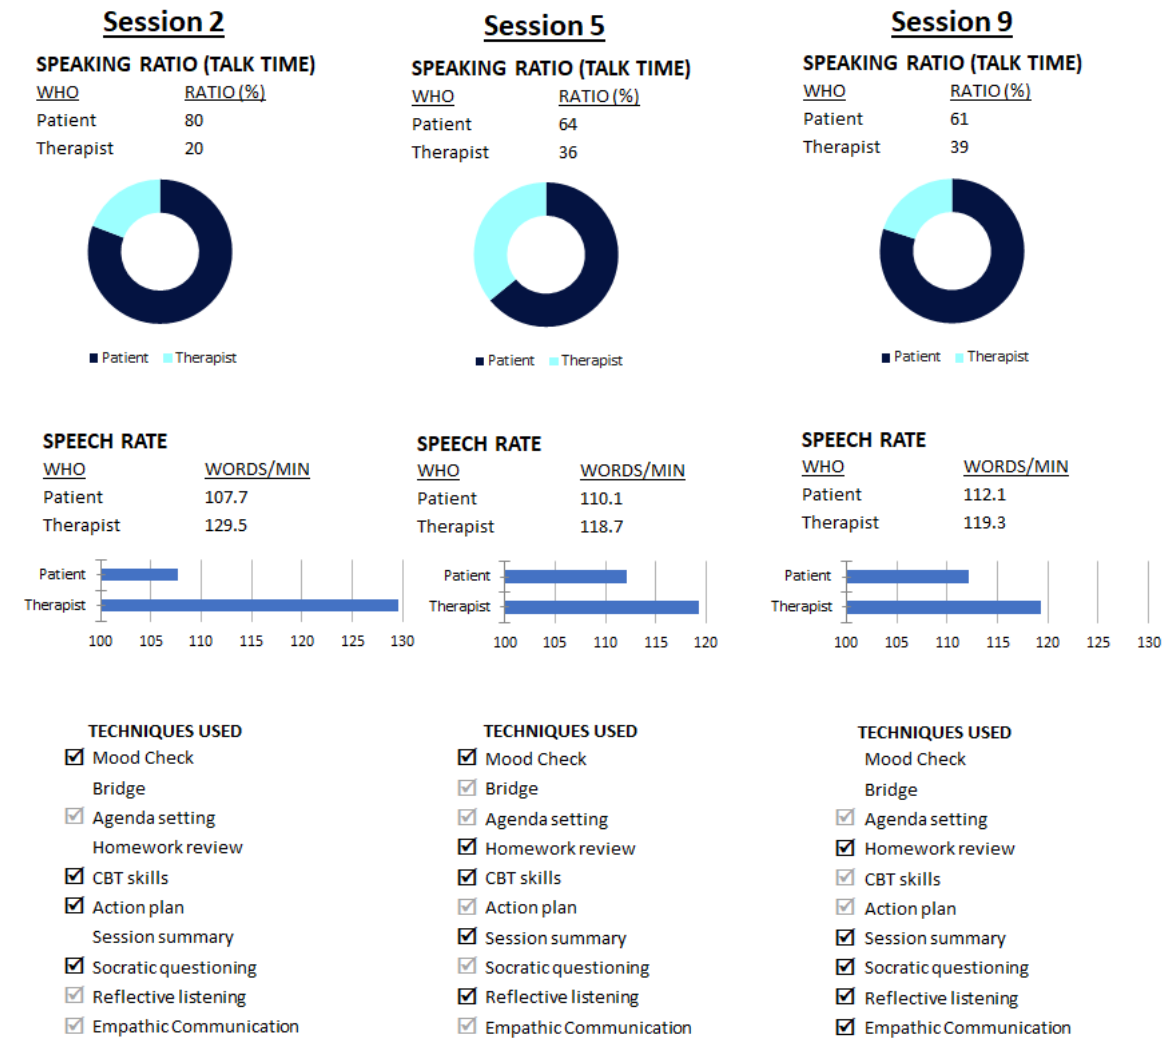
Figure 1. Screenshots illustrating some of the Eleos Health platform process features. CBT: cognitive behavioral therapy; Speaking Ratio: proportion (%) of time spent speaking during the session; Speech Rate: speed of words per minute; Techniques Used: intervention strategies employed by the therapist during the session and automatically identified by the platform. Techniques used 3 times or more are indicated with a black checkmark, techniques used once or twice are denoted with a grey checkmark, and interventions not employed in the session do not have a